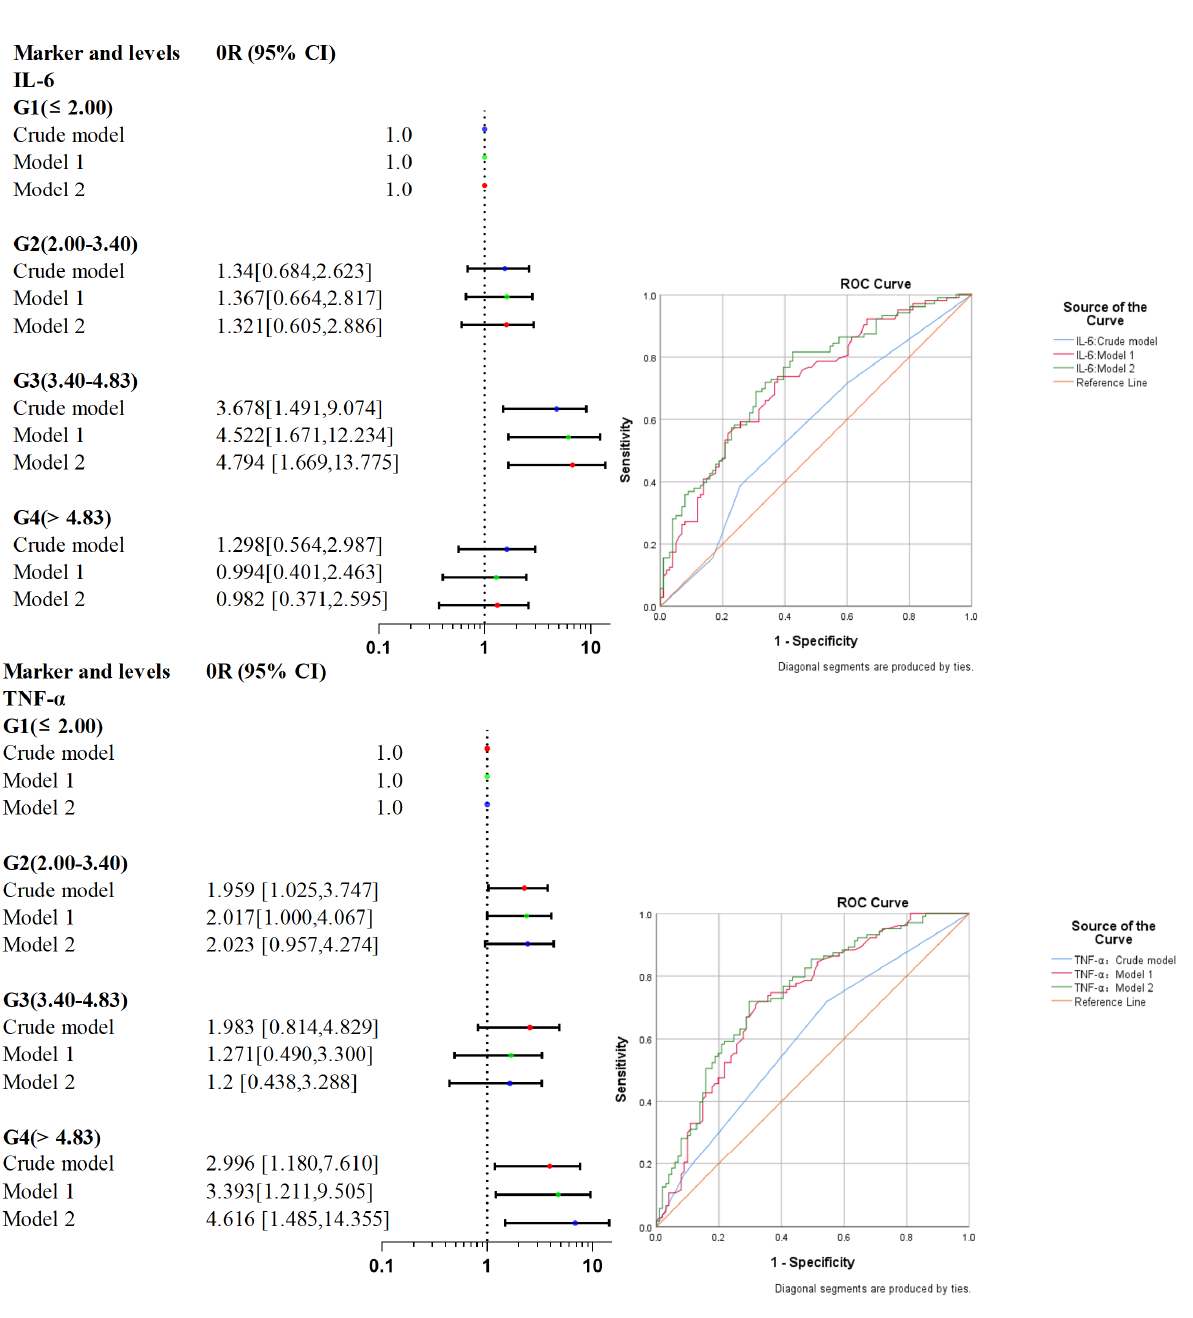
Figure 3. Risk in IL-6 and TNF-alpha grouping in correlation with the prognosis of MMD.